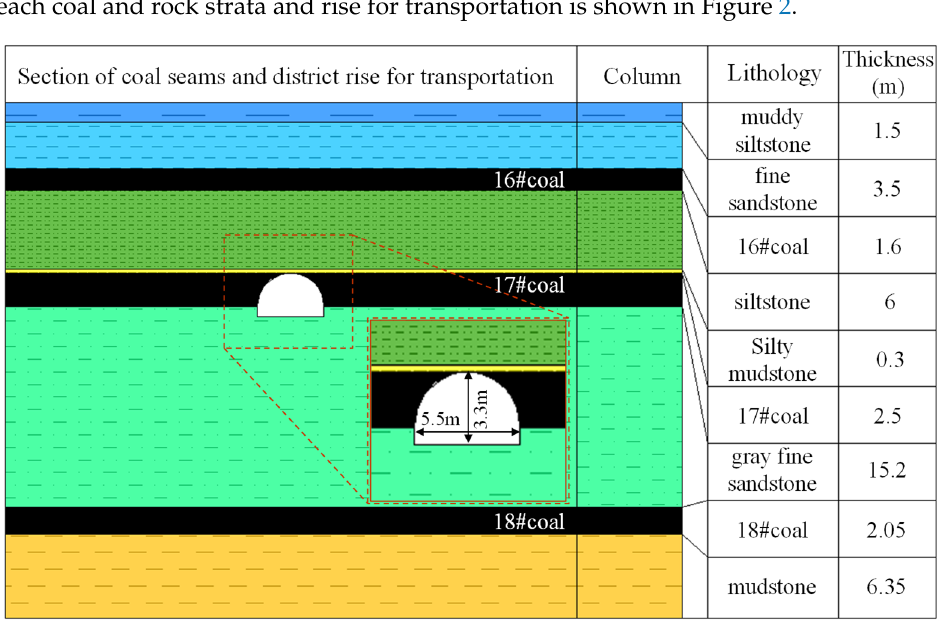
Figure 2. Strata histogram in this research.